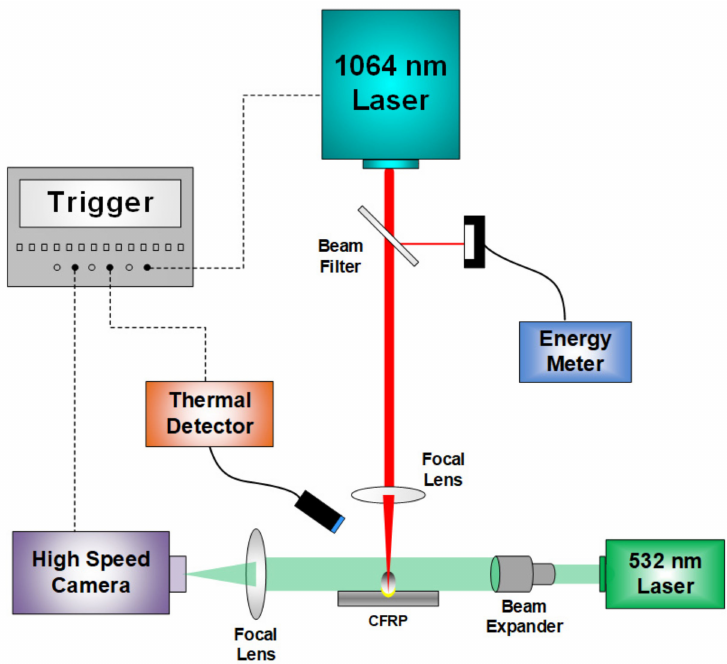
Figure 1. Schematic diagram of experimental